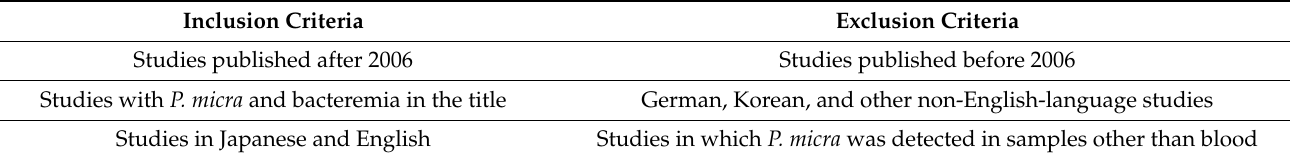
Table 1. Inclusion and exclusion